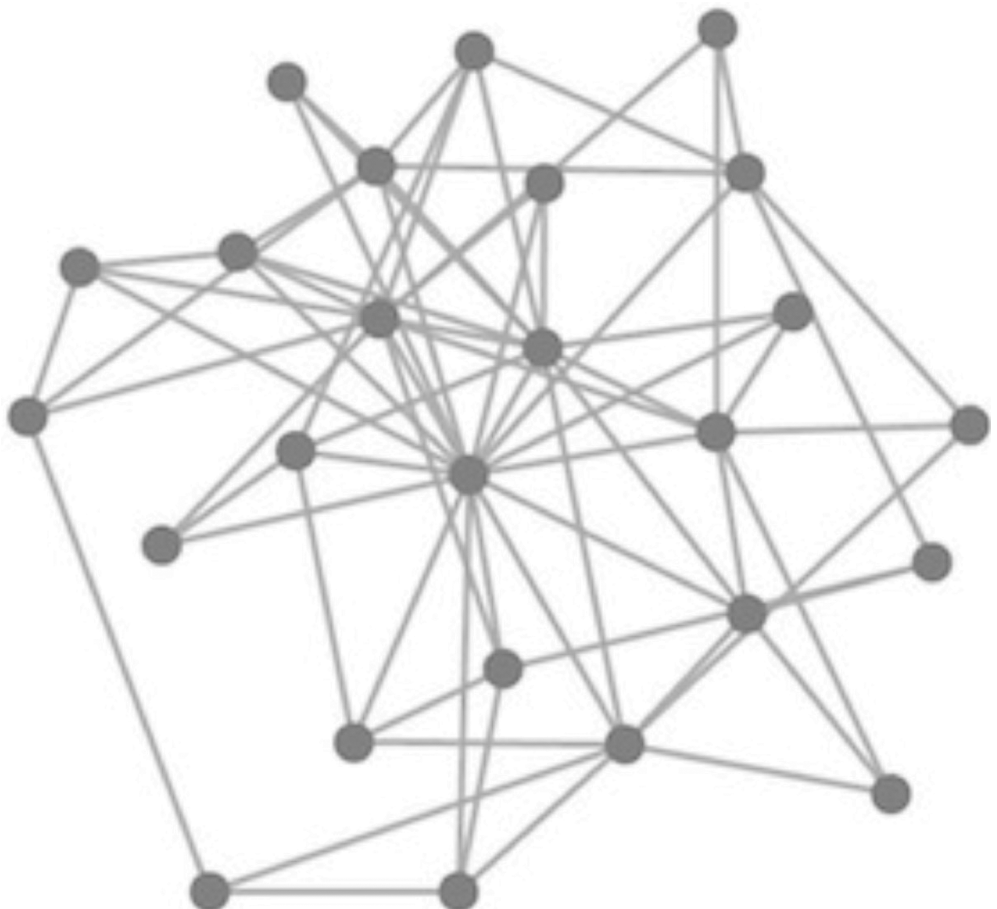
Fig 2. A visualization of a social network, used as the stimulus in the experiment. The image appeared to the participants exactly as it appears to you, the reader.